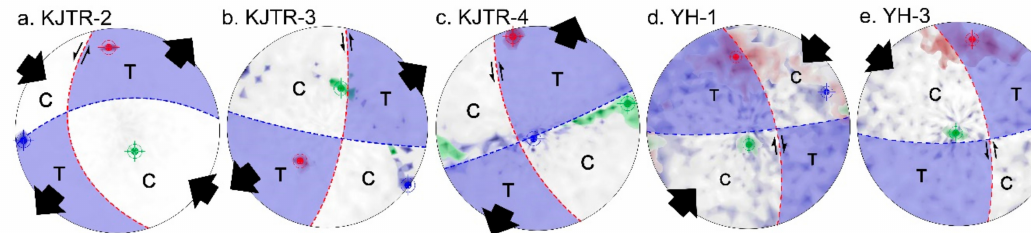
Figure 8. Stereograms showing the SPO result of KJTR-2 ( a ), -3 ( b ), and -4 ( c ), and YH-1 ( d ) and -3 ( e ) samples analyzed by their focal mechanism (lower-hemisphere, equal-area projection). The direction in which the tensile strain works is colored blue. All samples except the YH-1 sample shows a sinistral type strike slip fault. T, tensile strain and C, compressive